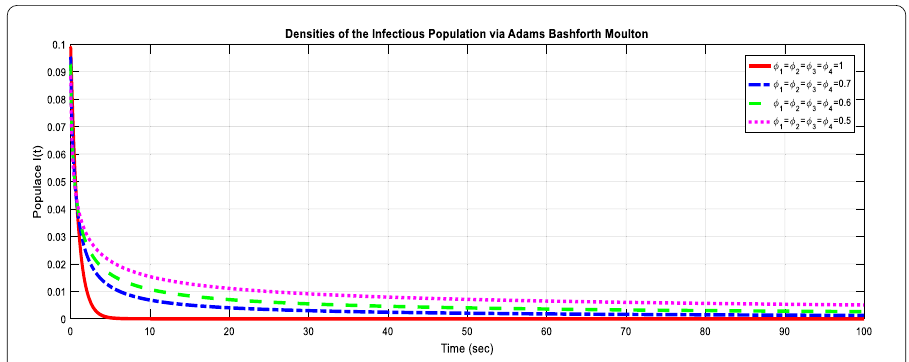
Figure 27 Dynamic of populace I ( t ) by varying the value of φ